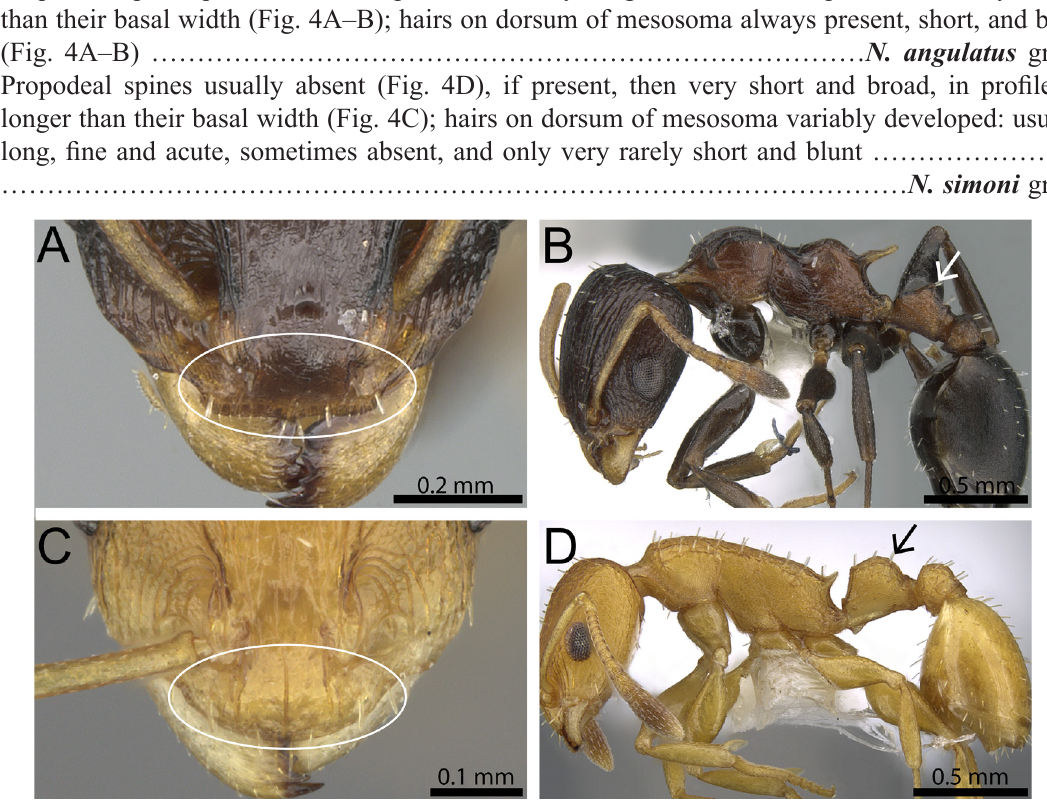
Fig. 3. Anterior cephalic dorsum (white ellipse around anterior clypeus) and body in profile. A–B . N. humerosus (Emery, 1896) (CASENT0906196). C . N. angulatus (Mayr, 1862) (CASENT